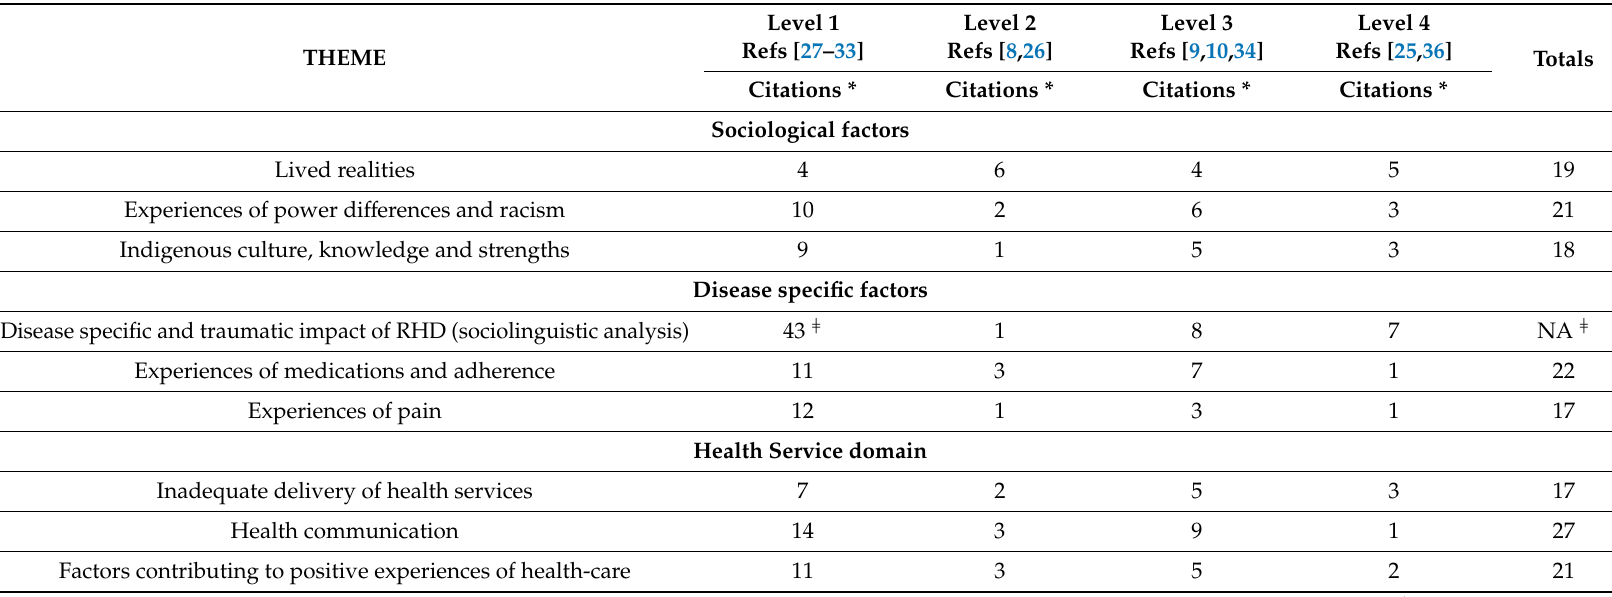
Table 2. Themes analysed according to hierarchy of evidence for practice (Daly et al.) [22] and